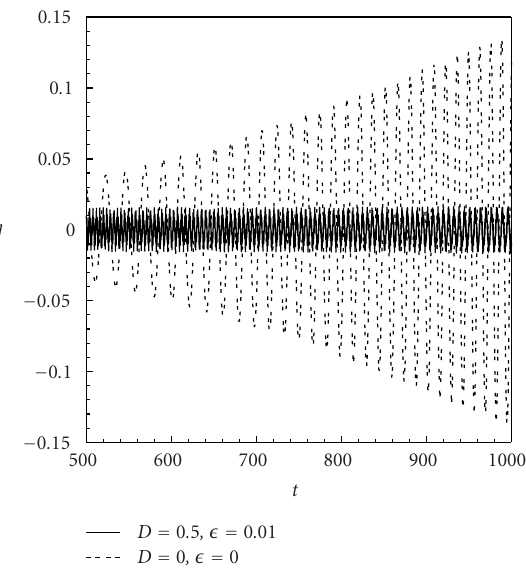
Figure 5.4. Wave motion due to impulse for fixed distance x = 1000; (cid:1) = 0 . 01, D = 0 .